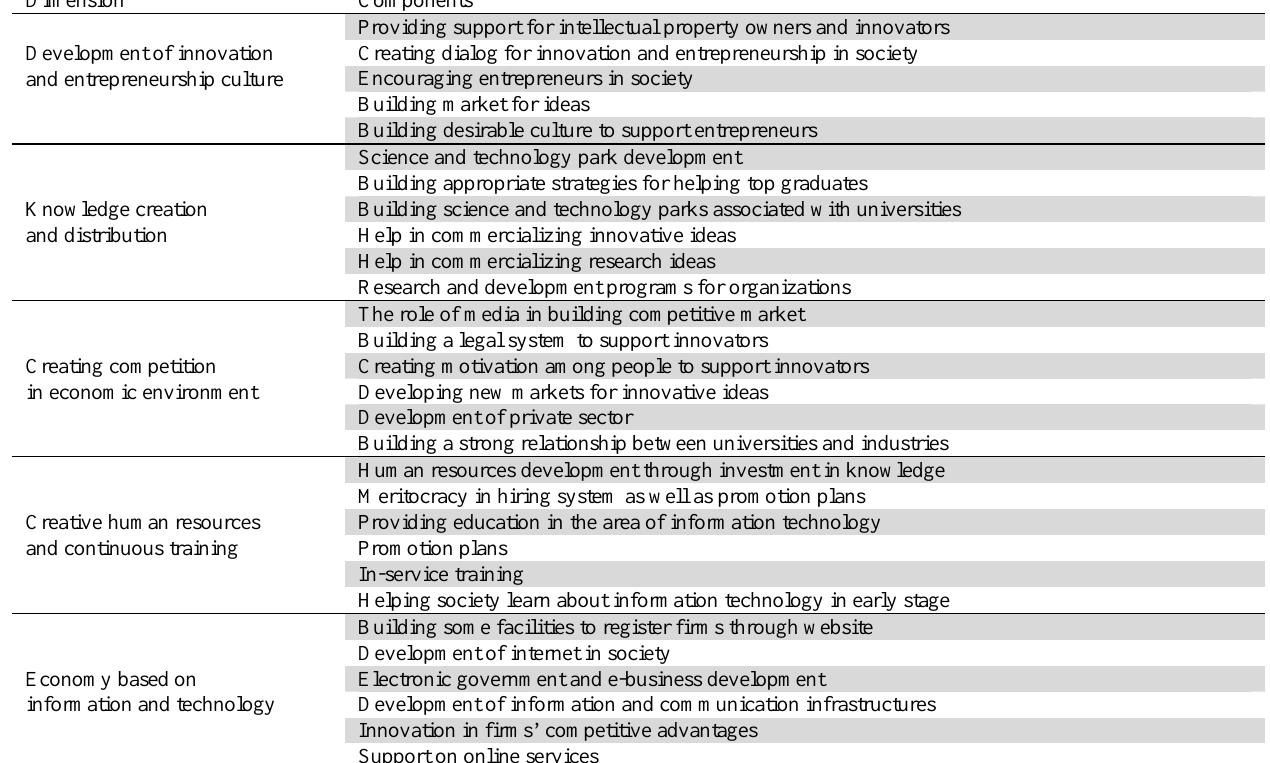
The summary of the implementation of GT technique on components influencing on KM economy